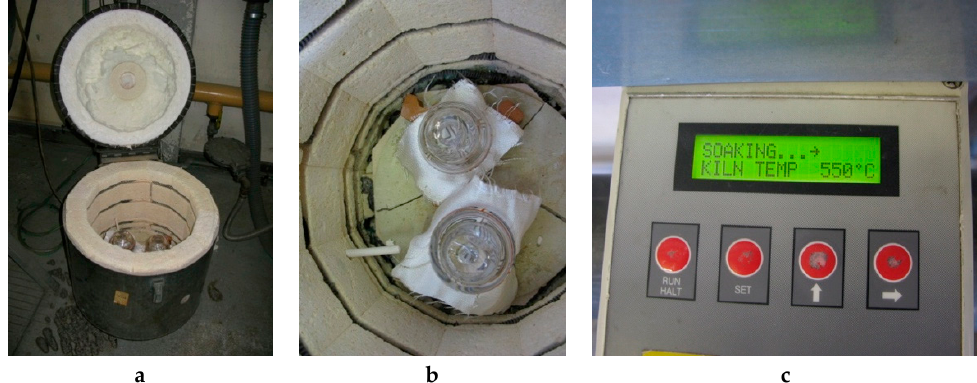
Figure 9. ( a , b ) Preparing the pick-up kiln for pre-firing. ( c ) The temperature of the pick-up kiln.